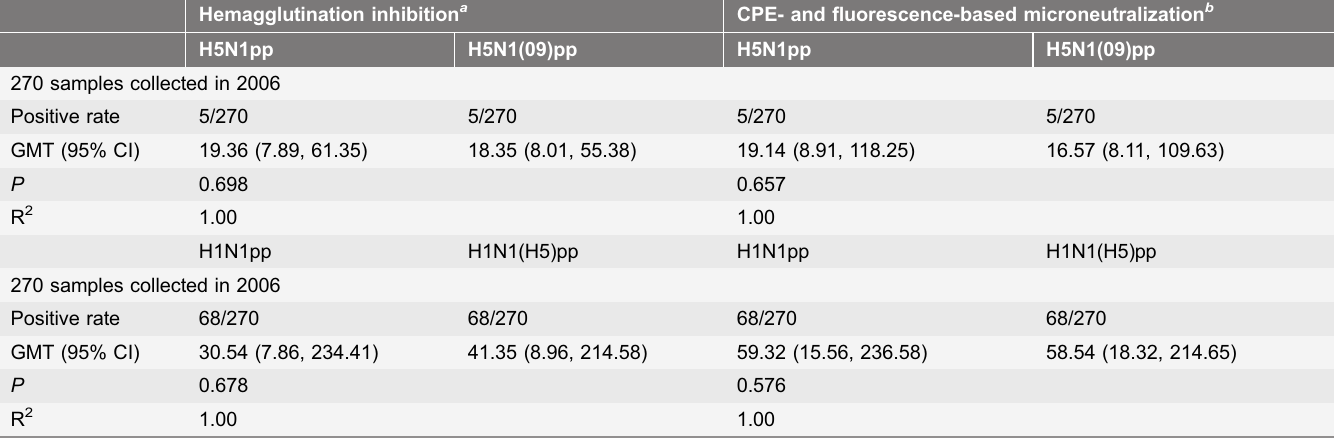
Table 3. Assessment of population nAb detection using reassortant pp.